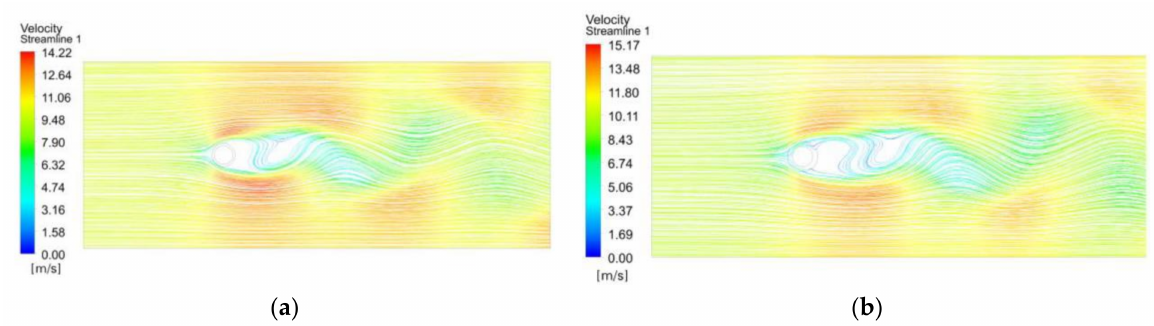
Figure 5. Fluid streamline result: ( a ) O–tower; ( b )